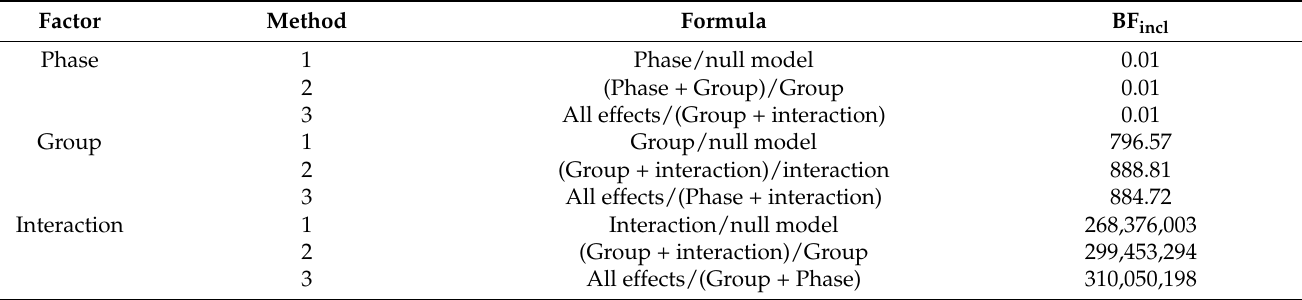
Table 3. Three methods for calculating the Bayes factor for the proportion